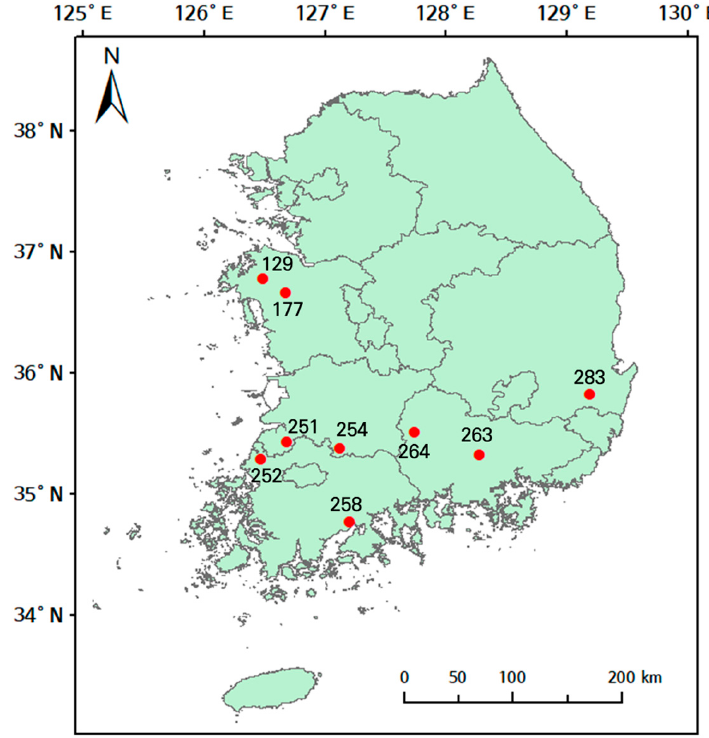
Figure 2. Measurement locations for the reference evapotranspiration (ET 0 ) by the Korea Meteorological Administration (KMA). The digits around the red points are the station identification number.